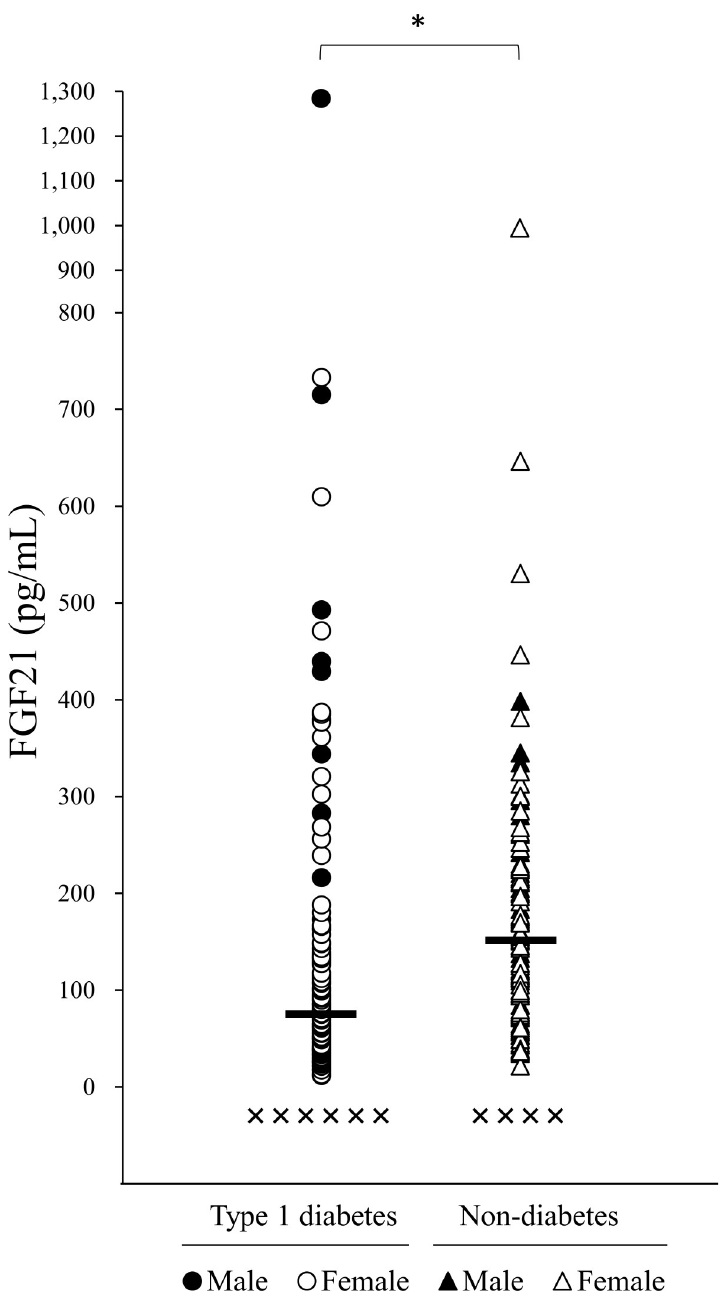
Fig 2. Distribution of the serum FGF21 concentration in T1DM and non-diabetic middle-aged and elderly subjects. Closed circles ( ● ) indicate male T1DM patients, and open circles ( ○ ) indicate female T1DM patients. Closed triangles ( ▲ ) indicate male non-diabetic participants and open triangles ( 4 ) indicate female non-diabetic participants. Cross mark ( × ) shows undetectable serum FGF21 levels in each group. Horizontal lines represent the median